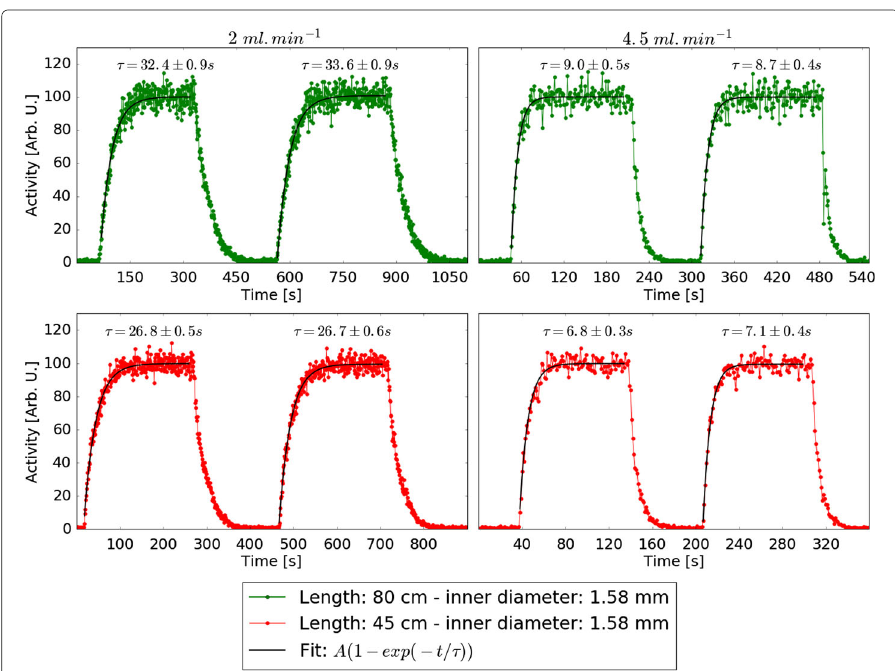
Fig. 12 Step functions for different flow rates and tubing lengths